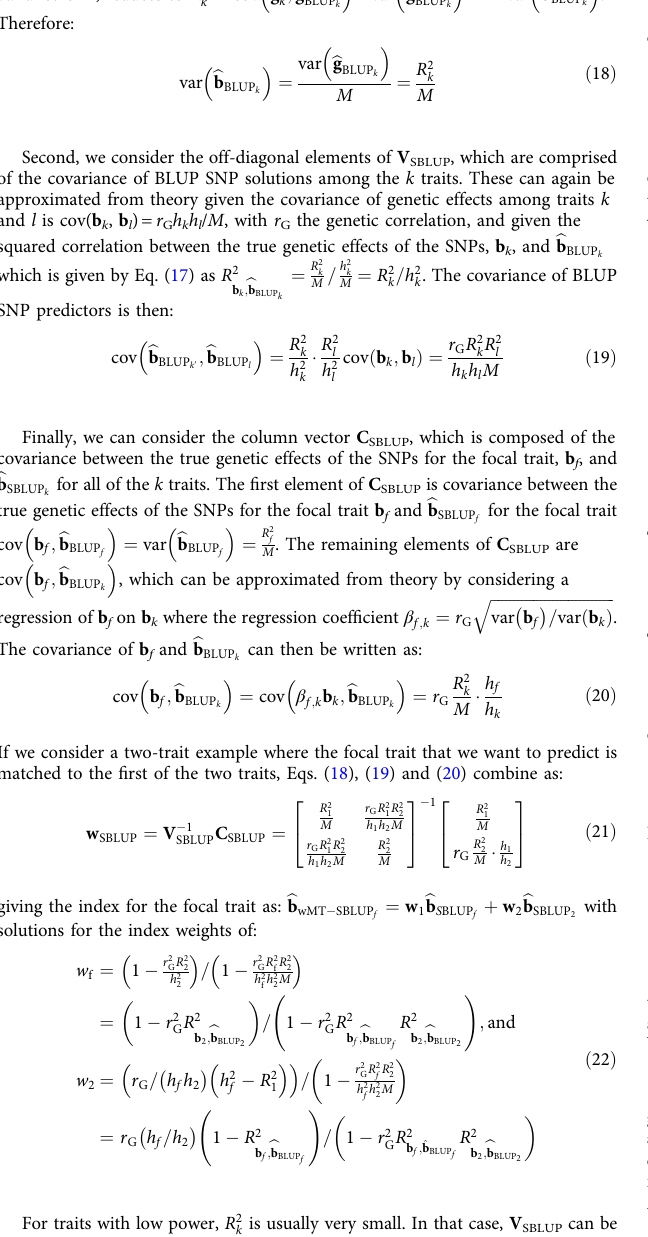
equally to BLUP solutions for the SNP effects or BLUP predictors for individuals of each trait as described in the main text in Eq. (1) through (3). LDpred aims to estimate the posterior mean phenotype that provides best unbiased